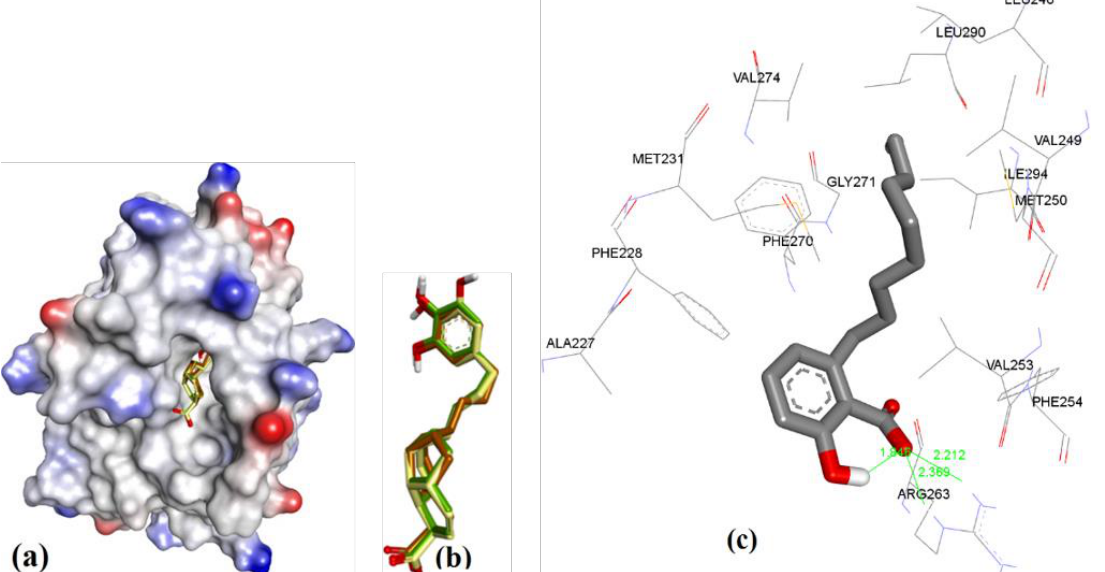
Figure 8. ( a ) The ionized solvent-exposed surface mapping of hMcl-1 along with the docked poses of 3a from MOE (in brown), AutoDock (in green), and VlifeDock (in yellow) show their fitting to the cavity. ( b ) Similar-pose ensemble clustering of all three poses was attained from the three different docking methods. ( c ) Binding mode of 3a with hMcl-1.